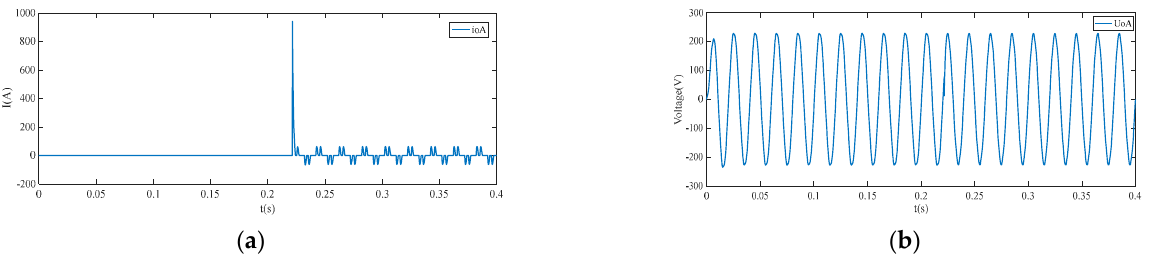
Figure 9. Simulation results of UPS with rectifier load using VSG control strategy and dynamic switching method ( a ) load current of phase A i oA , ( b ) load voltage of phase A U oA , C rc = 2200 µ F, R rc = 16 Ω .